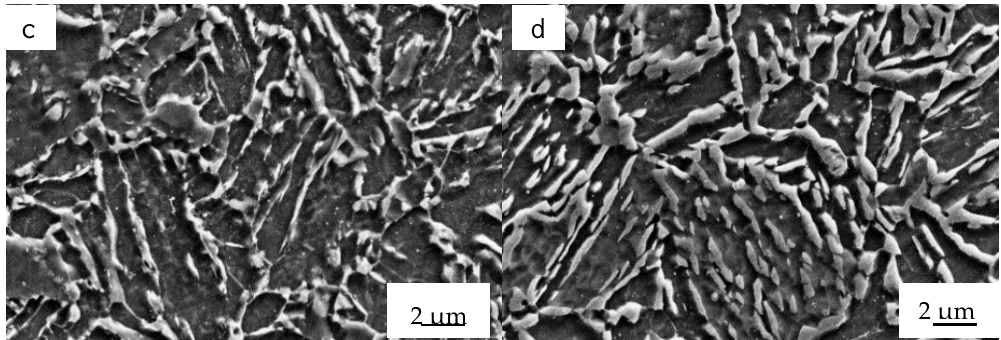
Figure 2. SEM images of the studied steel before ( a ) and after tempering at different temperatures: ( b ) 500 °C, ( c ) 600 °C, ( d ) 700 °C.